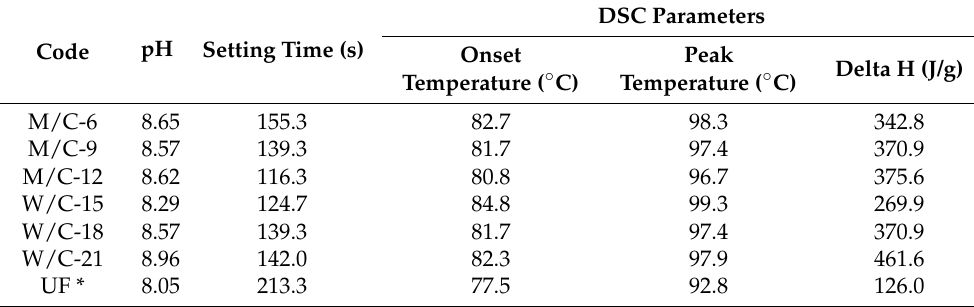
Table 4. Gel time, pH and differential scanning calorimetry (DSC) parameters of the MOC binders and UF as reference. Code pH Setting Time (s)